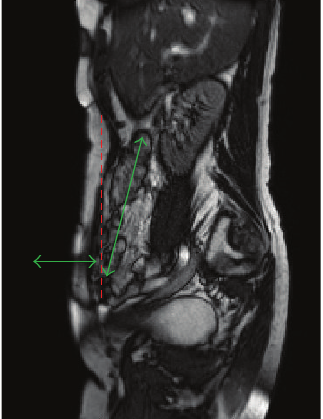
Figure 1: Schematic of the motion discontinuity in the abdomen during respiration. The horizontal green arrow indicates the pre- dominant motion of the abdominal wall whilst the mostly vertical arrow represents the predominant motion of the abdominal con- tents. The dotted red line indicates the approximate location of the motion